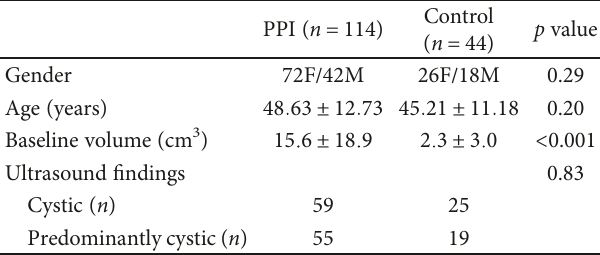
Table 1: Clinical characteristics of patients in the PPI and control groups.